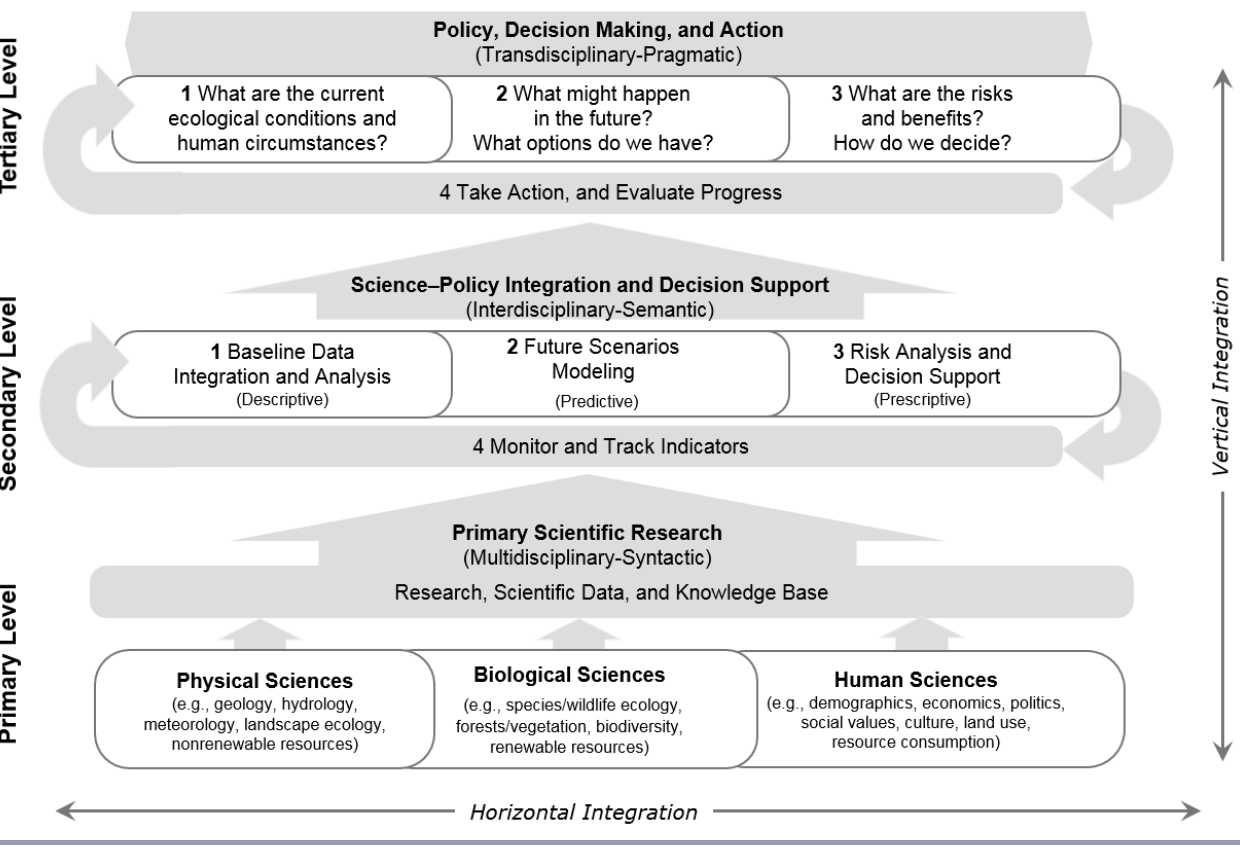
Fig. 6 . General reference framework for science–policy integration and adaptive management based on principles of information